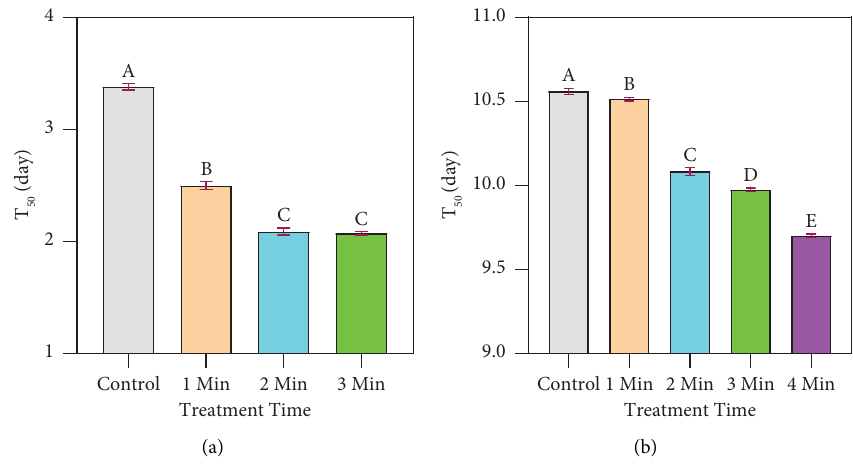
Figure 13: Time to 50% germination of (a) radish and (b) carrot seeds.